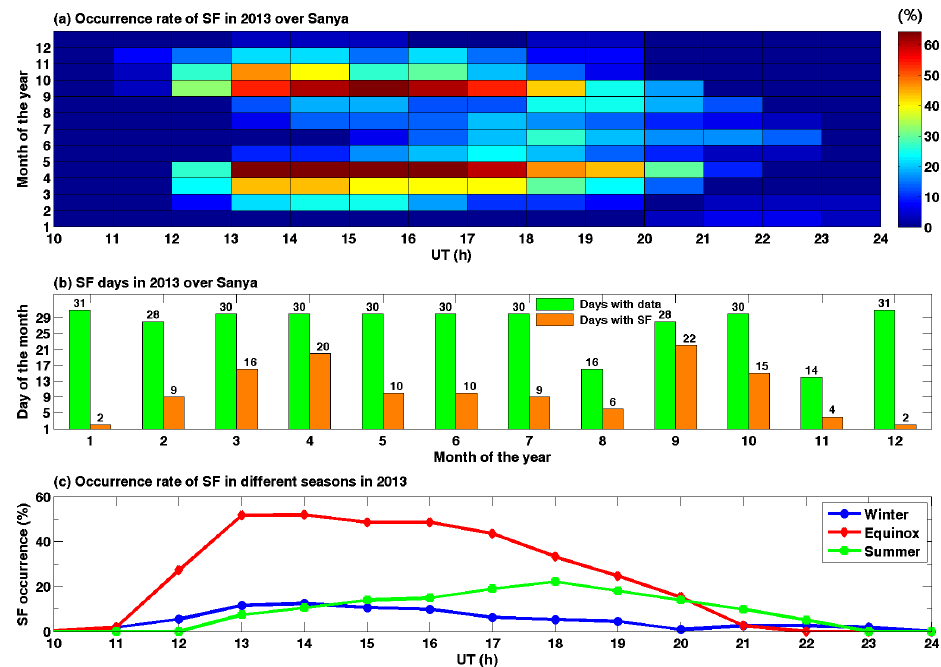
Figure 2. The statistics for SF occurrence in 2013 over Sanya. (a) The monthly occurrence rate of SF versus UT from January to De- cember 2013 at Sanya. (b) The SF occurrence days within the available data for January to December 2013. (c) The variations in the SF occurrence rate with UT in winter, equinox and